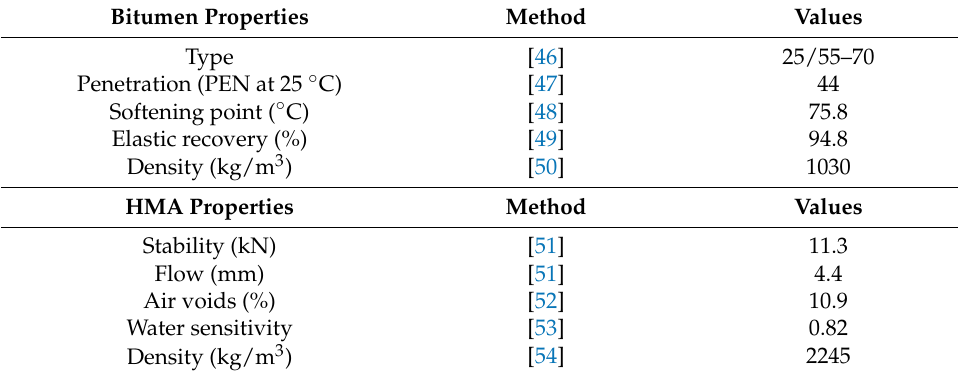
Table 1. Bitumen and HMA